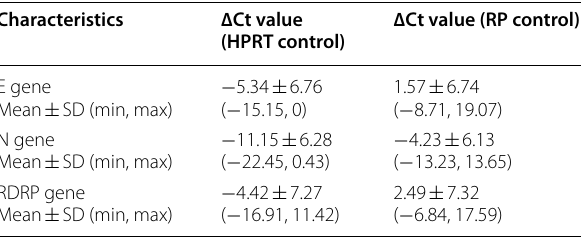
Table 3 The ∆Ct value emerged in RT‑PCR assay for the SARS‑ COV‑2.